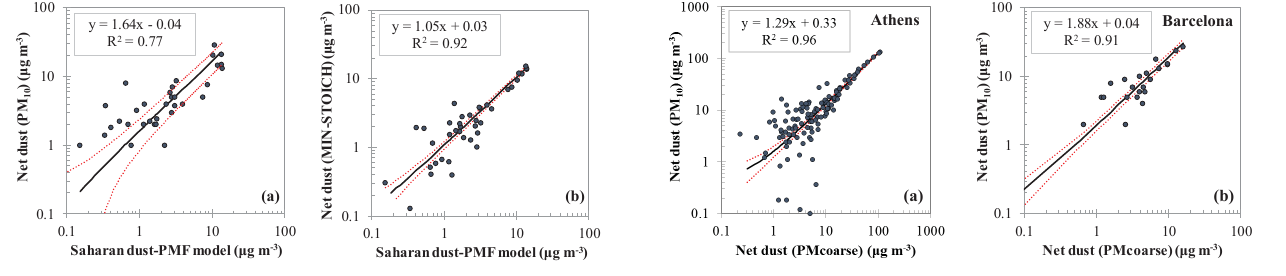
Figure 6. FLORENCE: Deming regression analysis of net dust con- centrations calculated by the PMF Saharan dust source versus net dust calculated by the EC methodology with input data: PM 10 re- gional background concentrations (left) or the PM 10 mineral com- ponent from stoichiometry (right). The black line corresponds to the linear regression equation, while the red dotted lines are the upper and lower bounds, at the 95% confidence interval.